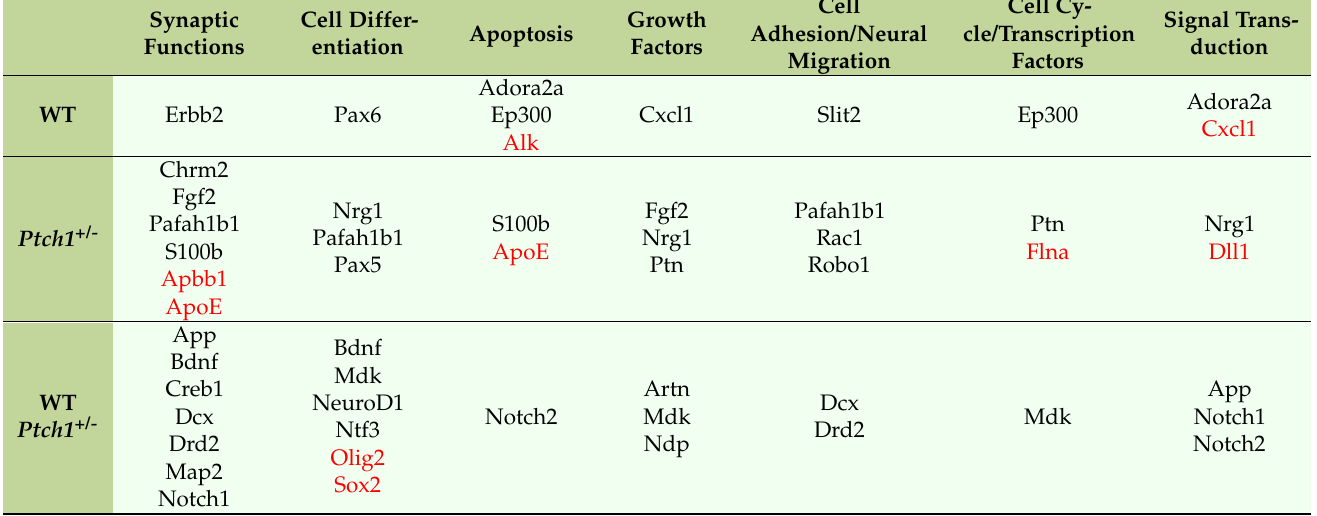
Table 1. Significantly deregulated genes in irradiated mice (WT or Ptch1 +/ − mice) vs. unirradiated CN (WT or Ptch1 +/